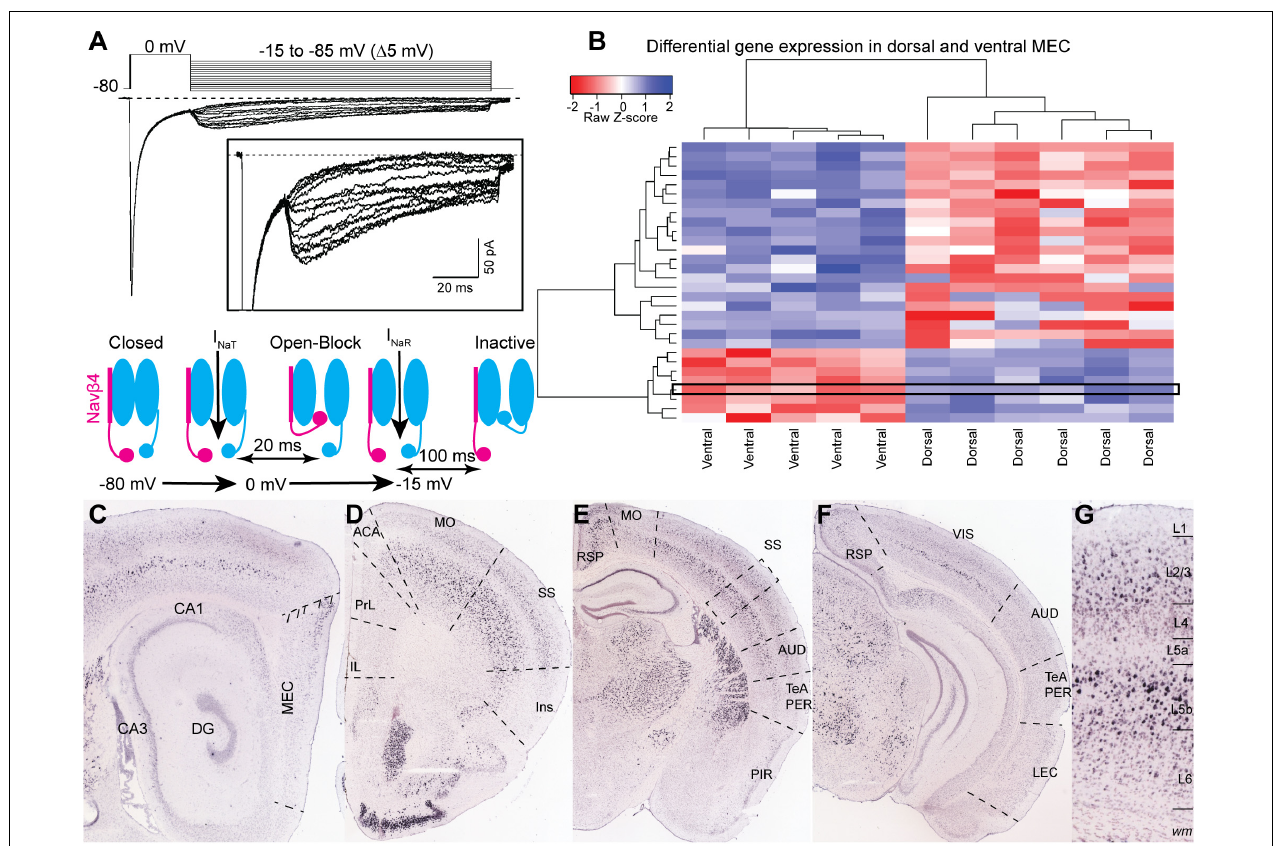
FIGURE 1 | (A) Representative voltage-clamp recording of sodium currents in a layer II neuron in MEC. Sodium currents were evoked by the voltage steps shown in the upper panel. A 20 ms step to 0 mV evoked INaT and was followed by a family of repolarizing steps from –15 to –85 mV to elicit INaR. Insert shows an expanded view of the INaR. The schematic in the lower panel shows the sequence of events generating INaR in sodium channels associated with a Nav β 4 subunit. (B) Differentially expressed gene analysis of data from Ramsden et al. (2015). Gene expression driven separation between ventral and dorsal medial entorhinal cortex from P60 mice. Scn4b is highlighted by a black rectangle and appears as one of 8 genes significantly enriched in the dorsal adult MEC. Heatmap displays 34 genes significantly up or downregulated in either ventral or dorsal MEC samples ( p -val. < 0.05, log 2 FC threshold ± 1.5, Benjamini-Hochberg corrected; hierarchical clustering performed by pairwise-Spearman correlation matrix). (C–G) ISH experiments from the Allen Institute showing the expression of scn4b across the cerebral cortex. (C) Scn4b is expressed in the dorsal MEC. (D–F) Expression of scn4b in the isocortex decreases from rostral (C) to caudal (F) regions. (G) Magnification of the somatosensory (SS) area highlighted by a dotted box in (C) . CA, Cornu Ammonis; DG, dentate gyrus; MEC, medial entorhinal cortex; IL, infralimbic; PrL, prelimbic; ACA, anterior cingulate area; MO, motor area; SS, somatosensory area; Ins, insula; AUD, auditory area; TeA, temporal association area; PER, perirhinal cortex; PIR, piriform cortex; RSP, retrosplenial area; VIS, visual area; LEC, lateral entorhinal cortex. Image credit: For (A) : adapted from Nigro et al. (2012) with permission from Elsevier. For (C–G) Allen Institute. 2004 Allen Institute for Brain Science. Allen Mouse Brain Atlas. Available from: